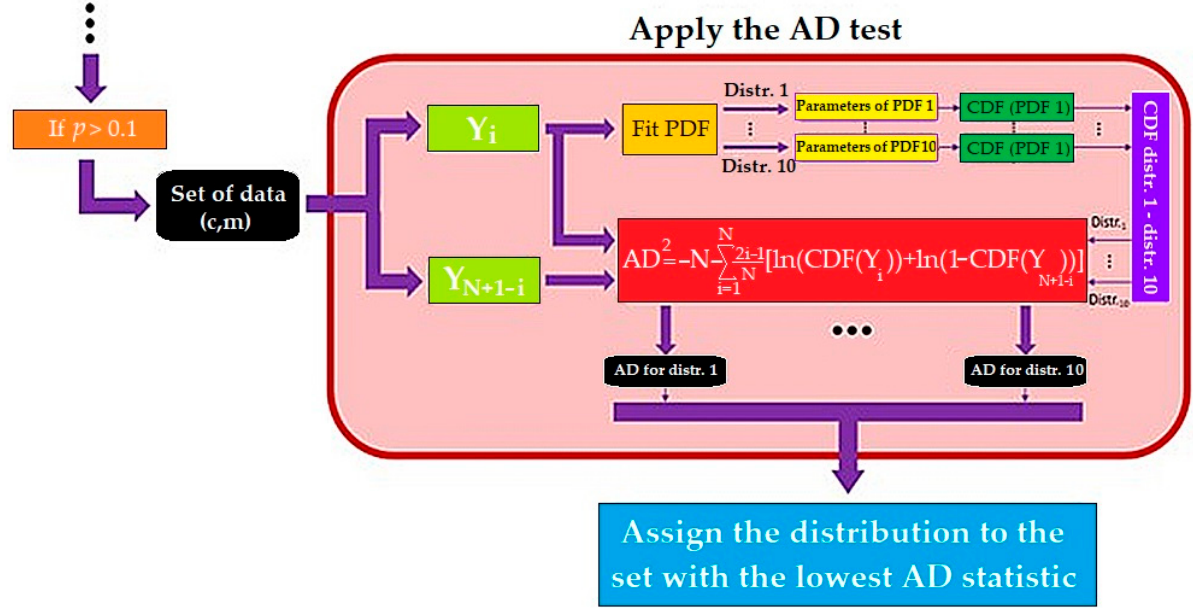
Figure 8. Step-by-step calculation of the Anderson–Darling (AD) test. Source: own elaboration.